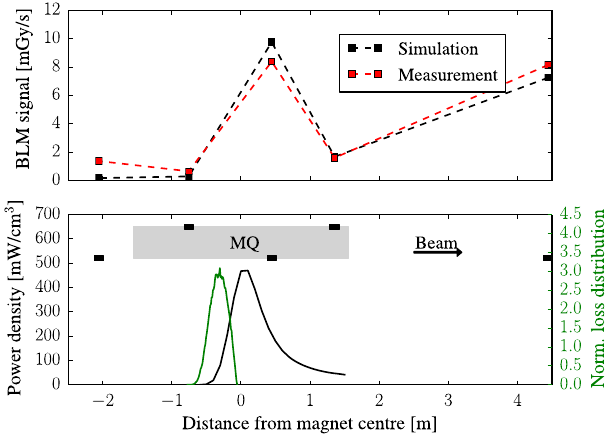
FIG. 20. Up: Detail of the comparison between the BLM signal and the simulated signal from FLUKA for the dynamic orbit- bump quench test. Down: FLUKA simulated peak energy density (black) deposited in the coils and MAD-X normalized distribu- tion of protons lost on the beam screen (green). The gray box indicates the magnet, black boxes indicate the locations of BLMs.